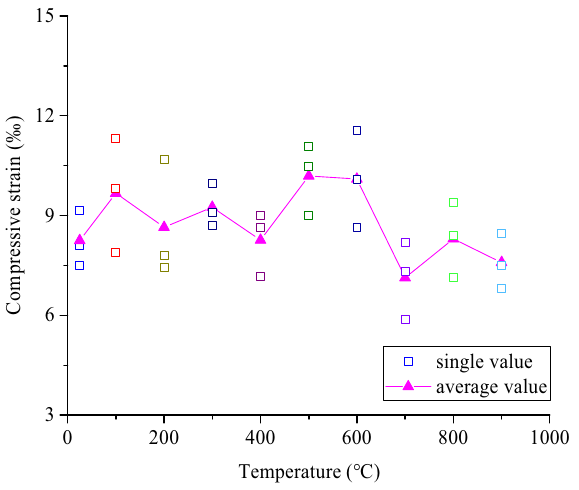
Figure 8. Relationship between the peak compressive strain and the treatment temperature of coarse sandstone samples.